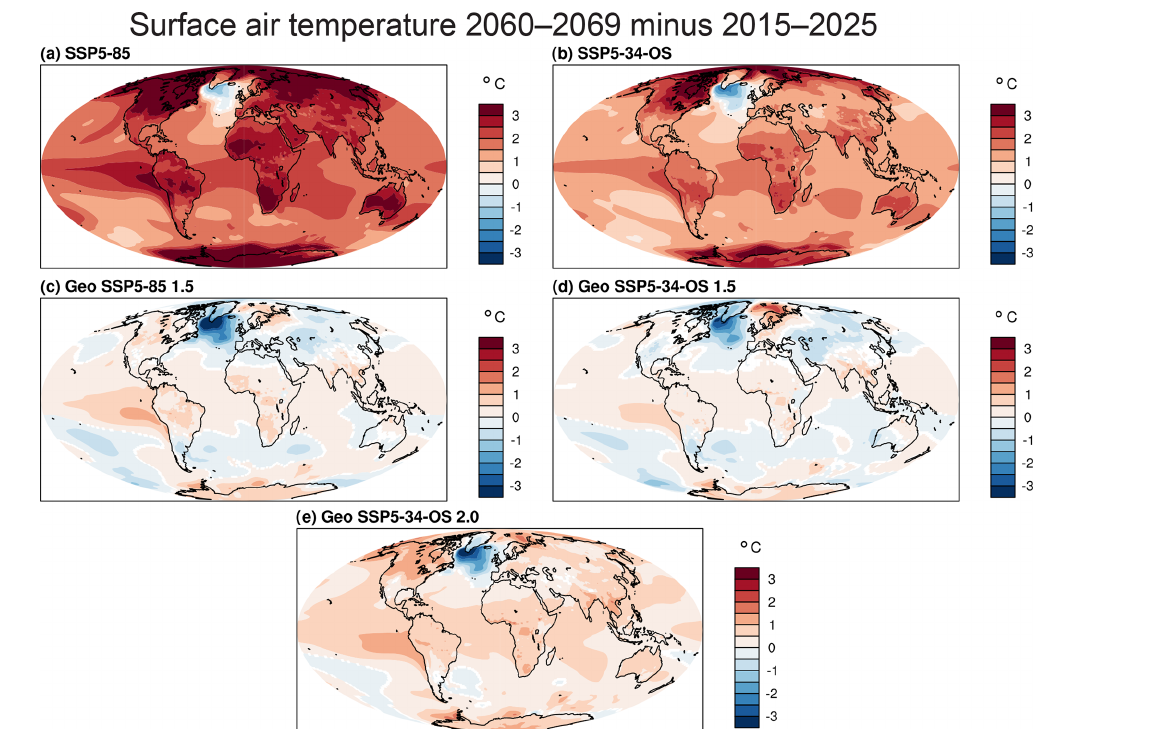
Figure 5. Ensemble-mean surface air temperature difference between 2060–2069 and 2015–2025 for SSP5-85 and SSP5-35-OS (a, b) , Geo SSP5-85 1.5 and Geo SSP5-34-OS 1.5 (c, d) , and Geo SSP5-35-OS 2.0 (e) . Regions shaded in color are significant with 95% confidence based on Student’s t test.